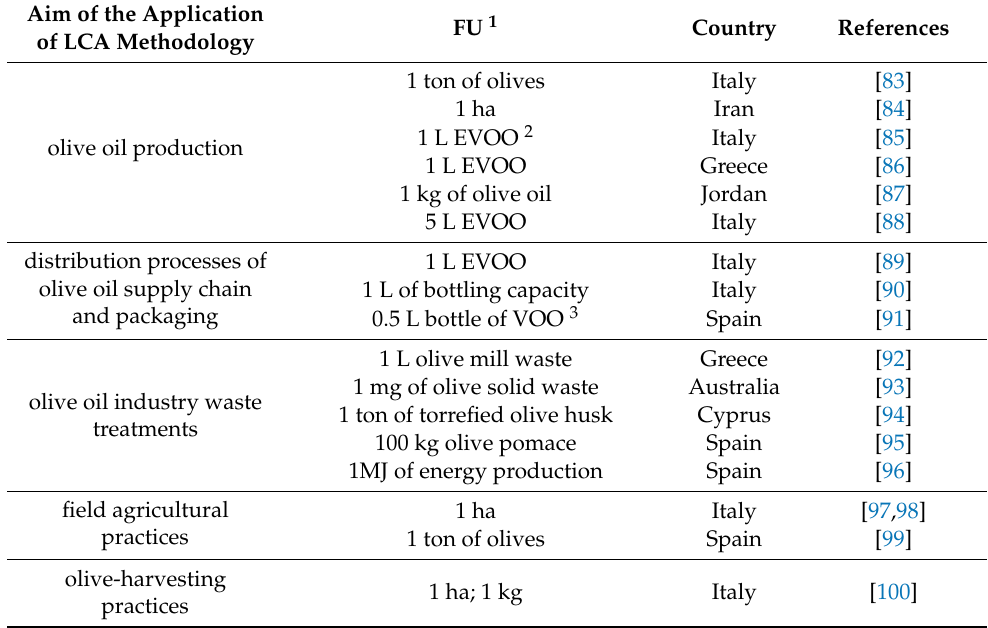
Table 2. Life Cycle Assessment (LCA) studies performed in the olive sector in the last 10